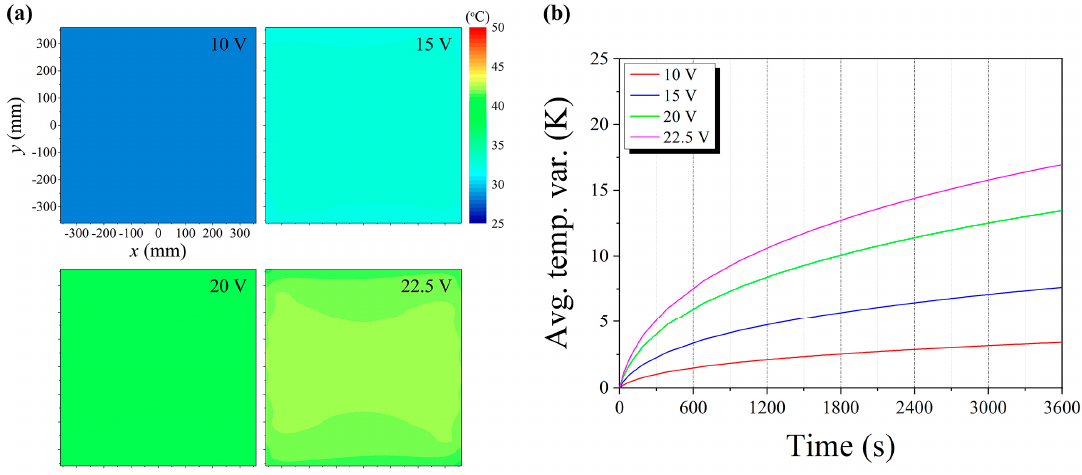
Figure 5. Transient temperature distributions and its histograms of the temperature values on the black surface of the portable and large-area blackbody system at a time interval of 600 s, for a bias voltage of 22.5 V: ( a ) numerical simulation; ( b ) experimental measurement. Note that because the total sampling numbers for the numerical simulation and experimental measurement differ from one another, the y-axis of the histograms indicated the normalized counts by calculating the number of the corresponding temperature value per sampling numbers. 5.2. Signal Transfer Function (SiTF), Noise-Equivalent Temperature Difference (NETD), and Emissivity of Portable and Large-Area Blackbody System